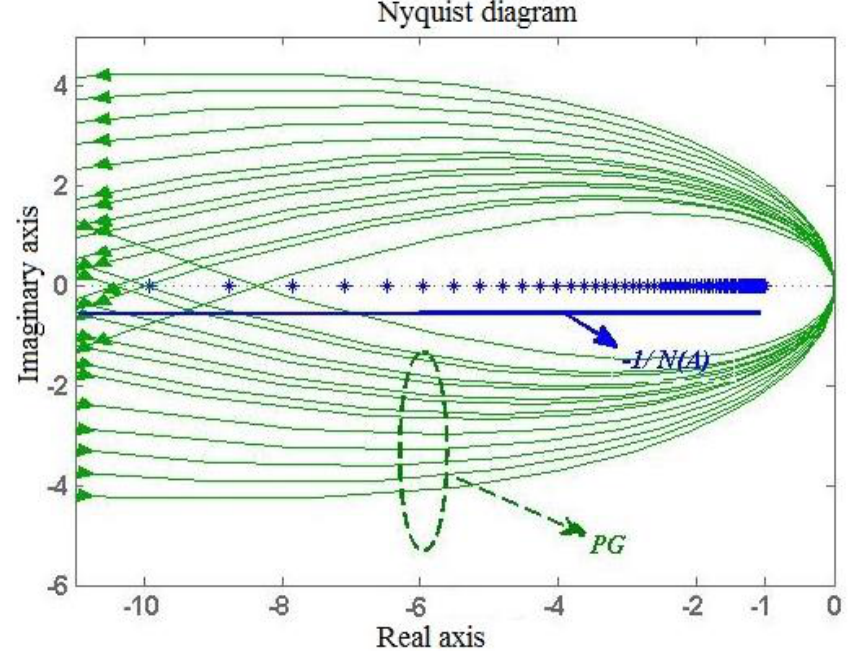
Figure 5. Limit cycle condition. Here, the Nyquist plot of the open-loop system PG (for 15 randomly generated plants from Equation (9)) and the line − 1 / N(A) are denoted by ‘solid green line’ and ‘solid blue line with *’, respectively.